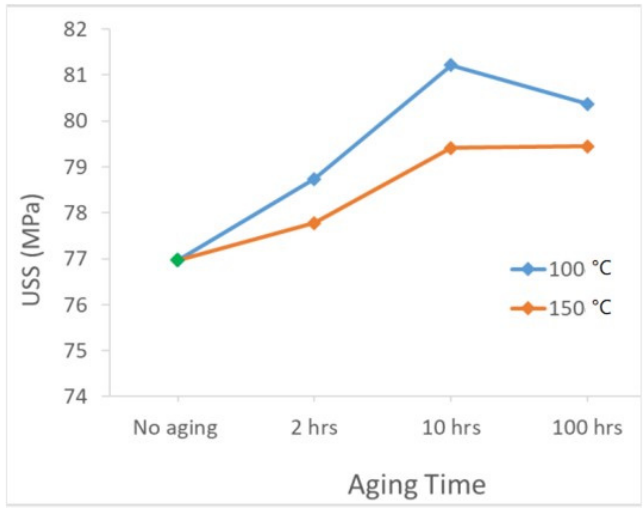
Figure 12. Comparison of the USS for samples thermally aged at 100 °C and 150 °C.